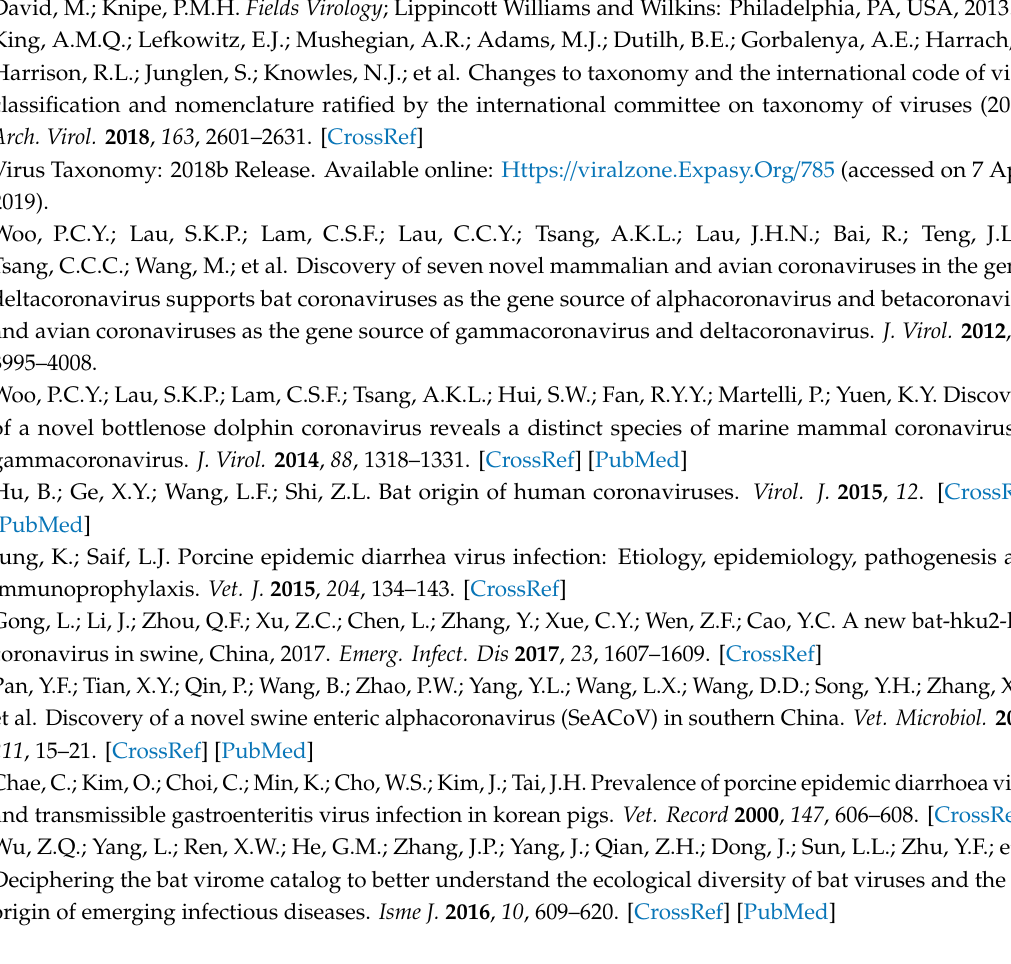
Figure S1: western blot analysis of the expression of accessory proteins. Figure S2: Apoptosis analysis of ORF9 proteins of BtCoV / Rh / YN2012. Figure S3: Functional analysis of ORF3a, ORF3b, ORF4b, ORF8 and ORF9 proteins on the production of Type I interferon. Figure S4: Functional analysis of ORF3b, ORF4a, ORF4b, ORF8 and ORF9 proteins on the production of NF- κ B. Figure S5: Characteristic of BtCoV / Rh / YN2012 spike mediated pseudovirus. Table S1: General primers for AlphaCoVs genome sequencing. Table S2: Primers for the detection of viral sugbenomic mRNAs. Table S3: Di ff erent cell line susceptibility to BtCoV / Rh / YN2012 RsYN1-, RsYN3-, RaGD- and MERS-CoV-spike mediated